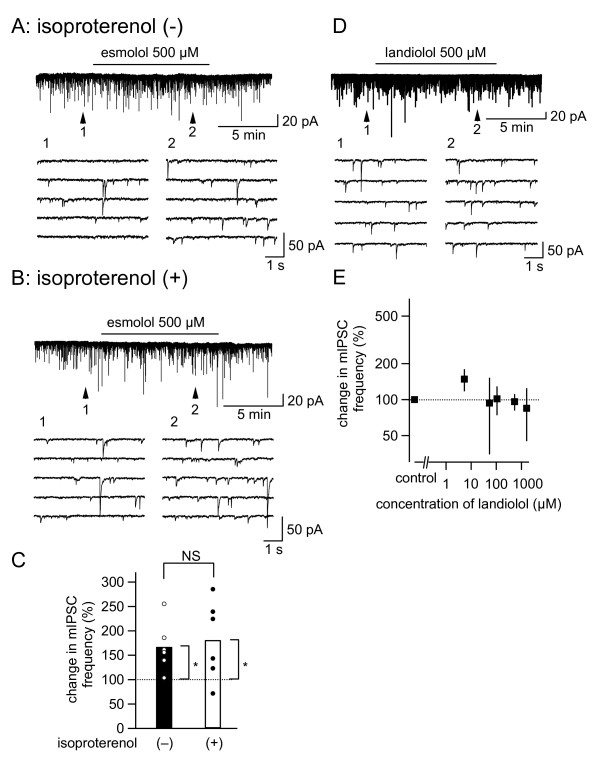
Effects of β receptor agonists on the effect of esmolol and the effects of another beta antagonist, landiolol, on synaptic inhibitory transmission in the caudal part of the spinal trigeminal nucleus (Sp5c) neurons. (A and B) Top: the membrane current recording of a neuron of the Sp5c in the absence (A) and presence (B) of 10-min prior administration of isoproterenol (100 μM). Recordings with "CsCl-based" internal solution. Esmolol was applied at the horizontal bar. Bottom of A and B: time-expanded continuous traces taken at points 1 and 2 in the top trace. (C) Summary of the effect of esmolol on mIPSC frequency in the absence (open circles; filled bar) and presence (filled circles; open bar) of isoproterenol. The bars show the average values. *, P < 0.05; Mann Whitney's U-test. NS, not significantly different; vs. pre-esmolol values. Each circle represents the data from one neuron (n = 6 neurons). (D) Top: the membrane current recording of a neuron of Sp5c using "CsCl-based" internal solution. Landiolol was applied at the horizontal bar. Bottom: time-expanded continuous traces taken at points 1 and 2 in the top trace. (E) Concentration-response relationship between landiolol and the changes in mIPSC frequency. The number of neurons used to estimate the mean values was 12 (control); 4 (5 μM); 4 (50 μM); 4 (100 μM); 10 (500 μM); 4 (1500 μM). Mann-Whitney's U test; vs. control (no drug application). The horizontal broken line indicates the control values (100%).